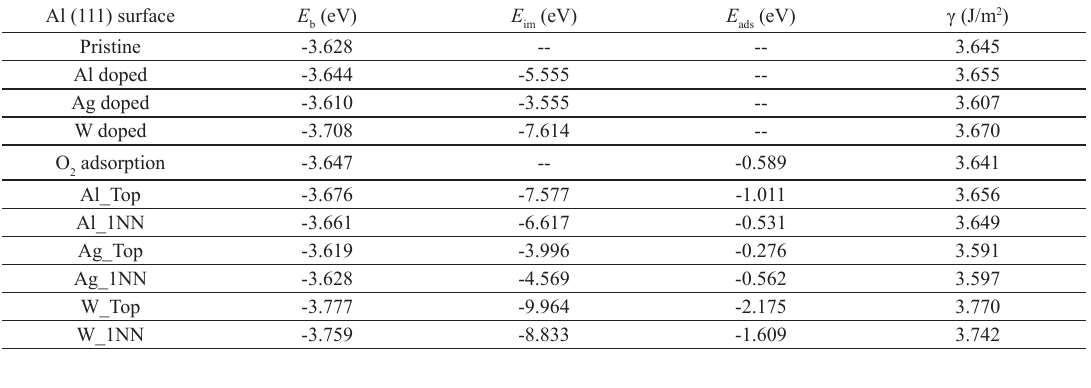
), adsorption energy ( E b